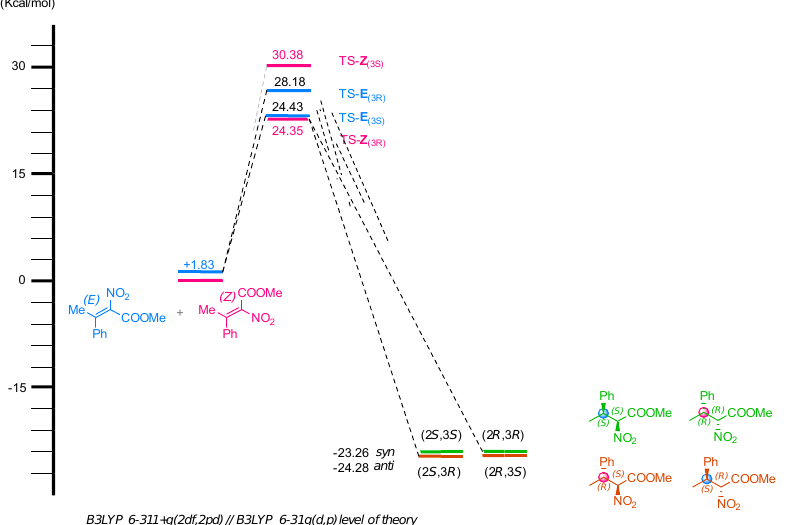
Figure 4. DFT calculations performed for the enantioselective reduction of tetrasubstituted nitroal-kene 3a .